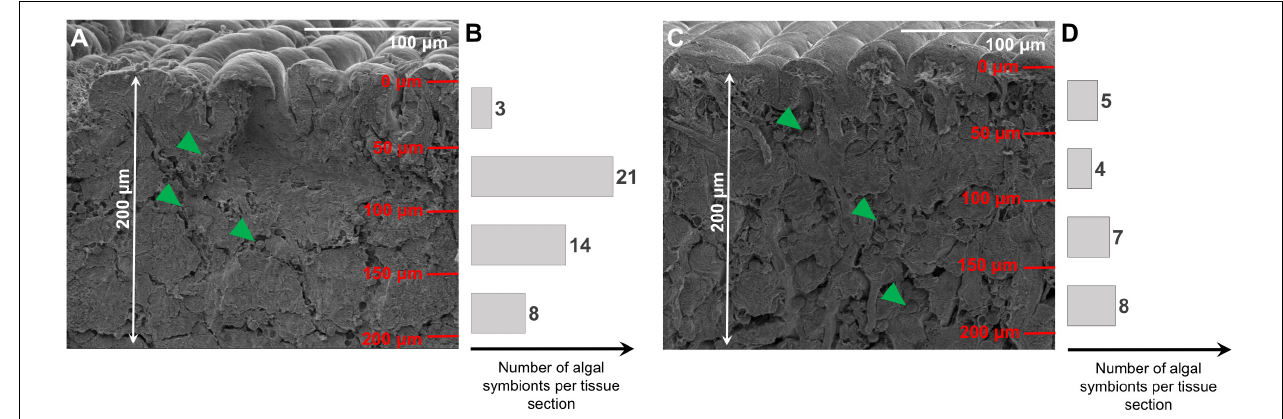
FIGURE 7 | SEM pictures of first 200 µ m of mantle tissue in a brown (A) and blue (C) phenotype of T. maxima. Bar plots represent numbers of Symbiodiniaceae in tissue at four different tissue layers (50 µ m increments), from tissue surface to a depth of 200 µ m into the mantle tissue. Algal symbionts (Symbiodiniaceae) are exemplarily highlighted with green arrows. Numbers of algal symbionts within each tissue section are presented as bars for the brown (B) and blue phenotype (D) .